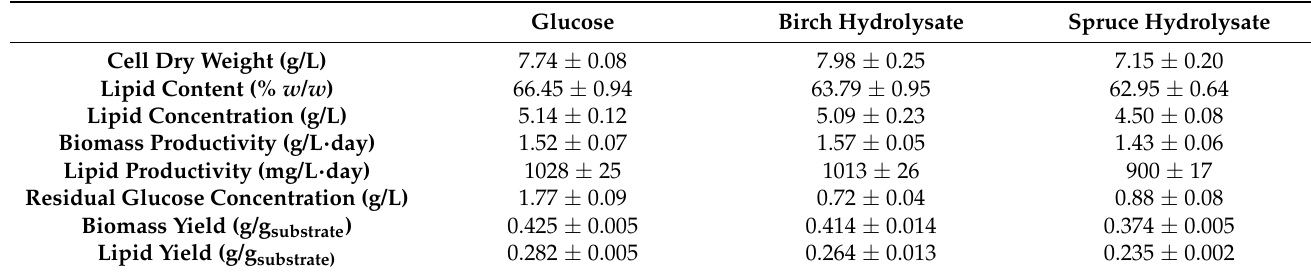
Table 2. Biomass and lipid synthesis in heterotrophically cultivated Pseudanabaena sp. Glucose Birch Hydrolysate Spruce Hydrolysate